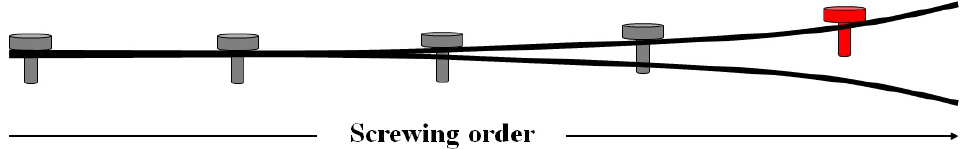
Figure 1. The red screw cannot join the two parts because of the screwing